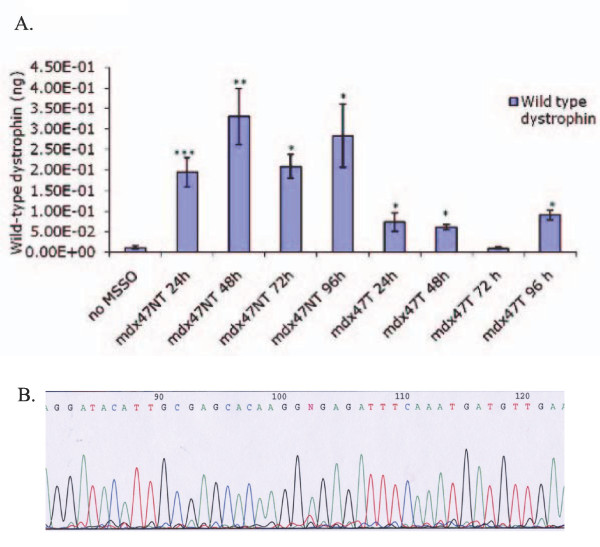
Quantitative measurement of dystrophin correction in primary cultures containing mdx5cv myoblasts at the DNA level and sequence analysis. A: Total genomic DNA was isolated from targeted myoblasts at various time points, 24 to 96 hours after introduction of ODNs, mdx47NT or mdx47T. Twenty-five nanograms of this DNA was subjected to absolute quantification by PCR analysis with a FAM labeled probe specific only for the wild-type dystrophin sequence. A standard curve had been previously generated using C2C12 (WT) genomic DNA and the amount of wild-type dystrophin has been extrapolated from this standard and is presented as nanograms of wild-type dystrophin. These data represent the average of three experiments that were analyzed in triplicate. Significance was measured by a Student's t-test and samples were considered significantly different with a p value of less than *0.05, **0.01, ***0.001. B: DNA sequence reaction of PCR products showing the chromatogram representing a mixed population at the targeted base (base 102) with adenine (green/corrected base) being the major peak and with thymine (red/mutant base) being a minor population within the reaction.